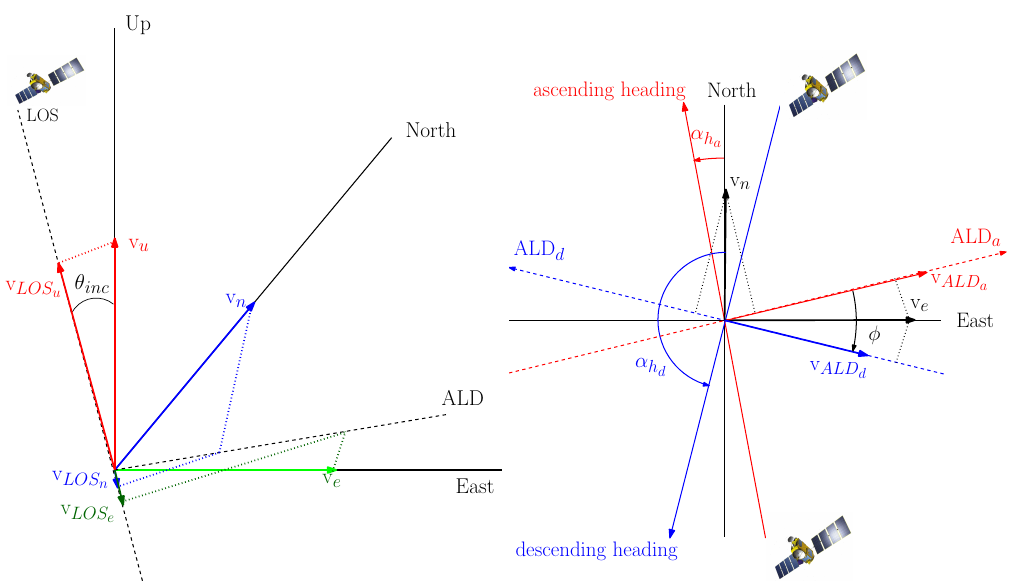
Figure 7. Geometry of the velocity decomposition to vertical and horizontal components. ( Left ) Projection of the up, east and north components of the 3D velocity vector to the ascending satellite LOS and ( Right ) different contribution of the horizontal components of the descending and ascending satellite passes. ALD a and ALD d vectors correspond to the descending and ascending azimuth look angle directions, respectively. Similar sketches can be generated for the descending imaging